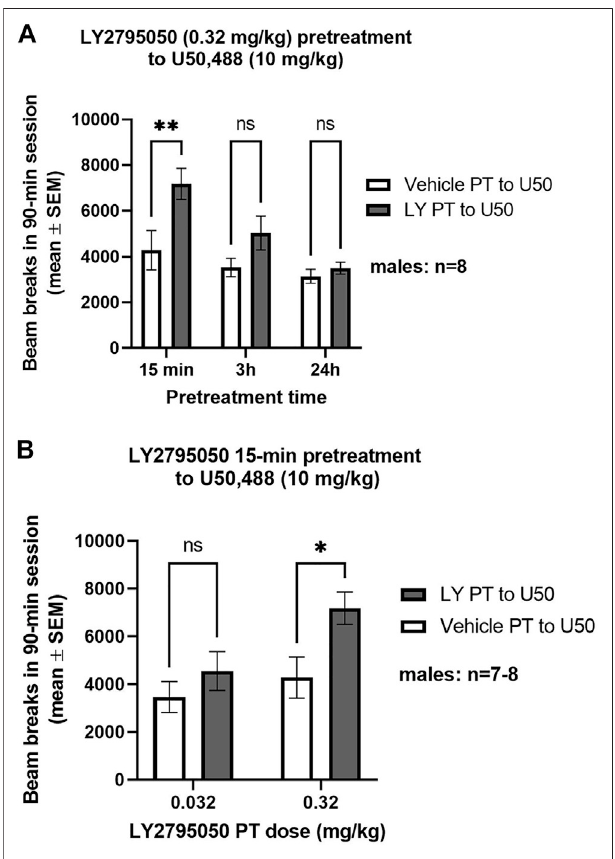
FIGURE 1 | KOR-antagonist effects of LY2795050 pretreatment to U50,488 inthe locomotor activity assay(in males). Total locomotor counts are shown for a 90-min session, starting immediately after injection of U50,488. (A) : Effect of LY2795050 (0.32 mg/kg or vehicle) given at different pretreatment times (15 min, 3 h, or 24 h) before U50,488 (10 mg/kg). (B) : Effect of different doses of LY2795050 (0.032 and 0.32 mg/kg, or vehicle) given 15 min before U50,488 (10